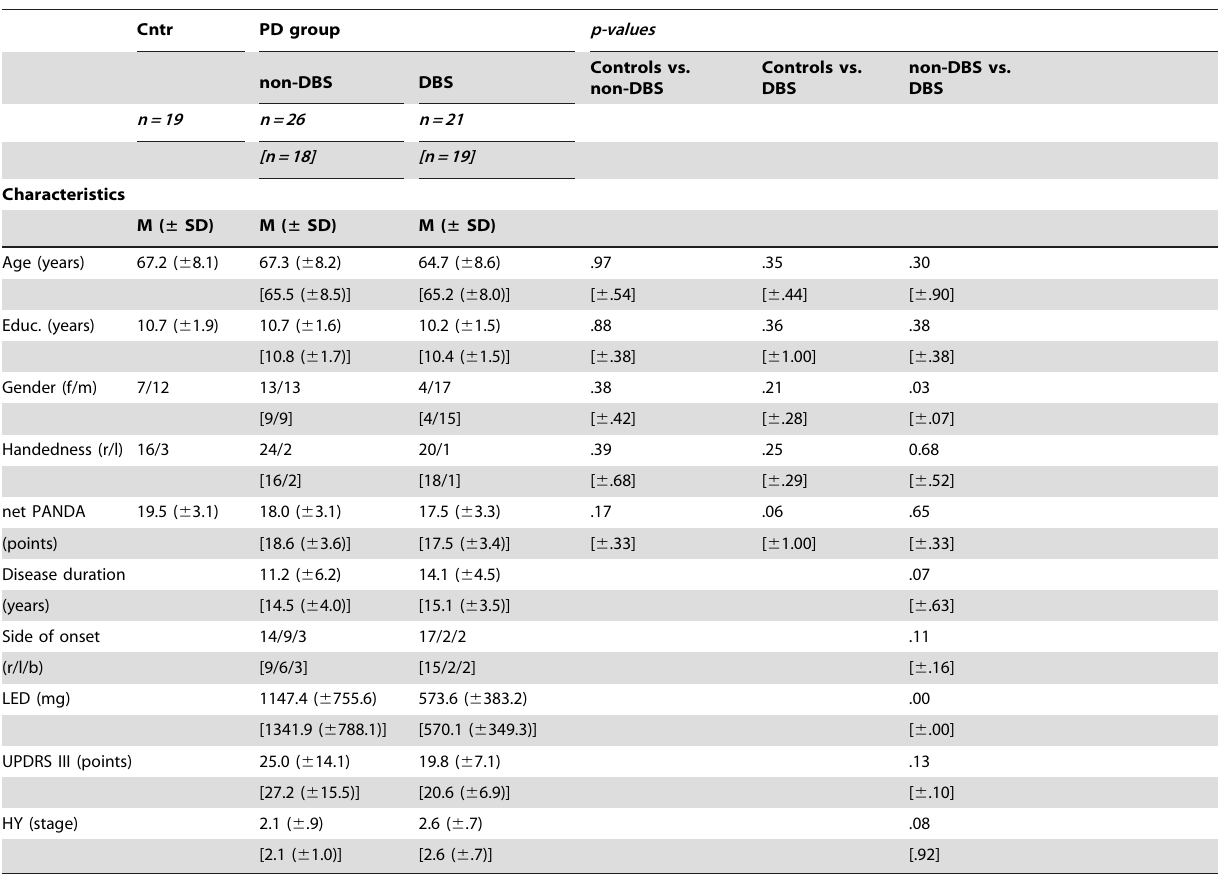
Table 1. Overview of participants baseline